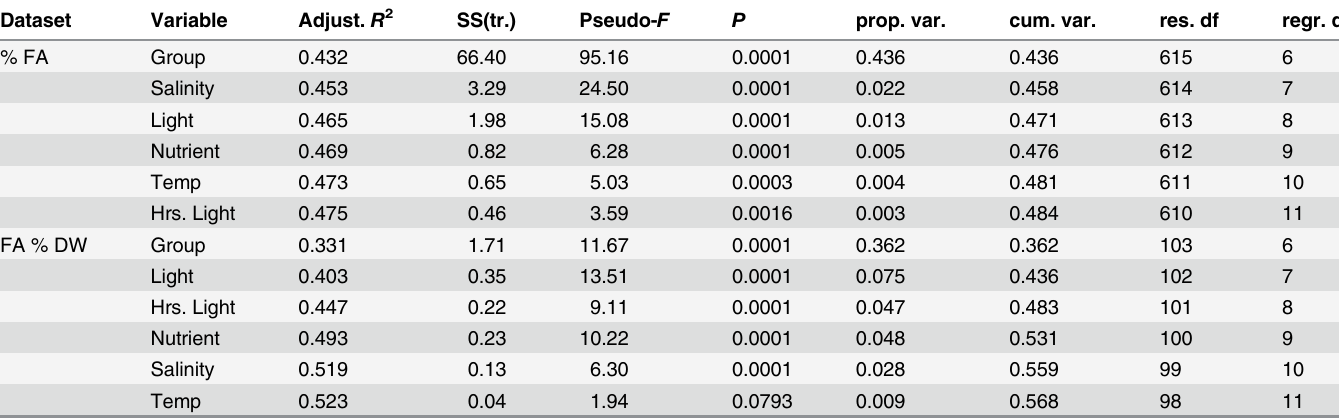
Table 1. Results of the DISTLM sequential step-wise tests.